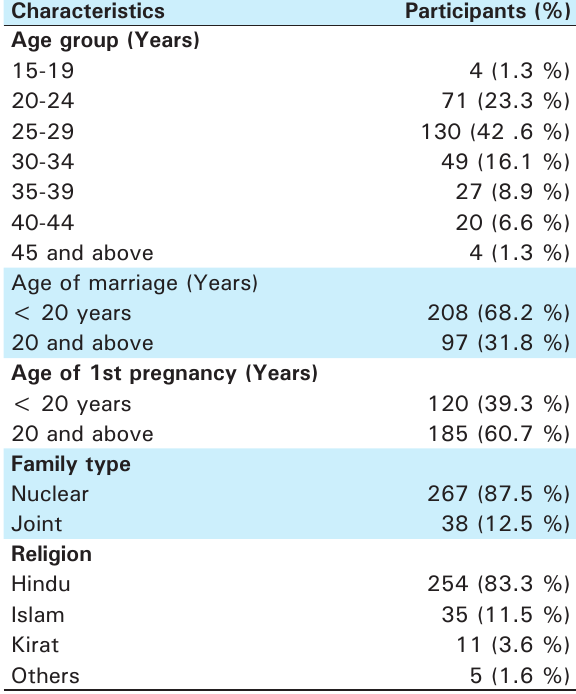
Table 2. Gender of the last child and use of